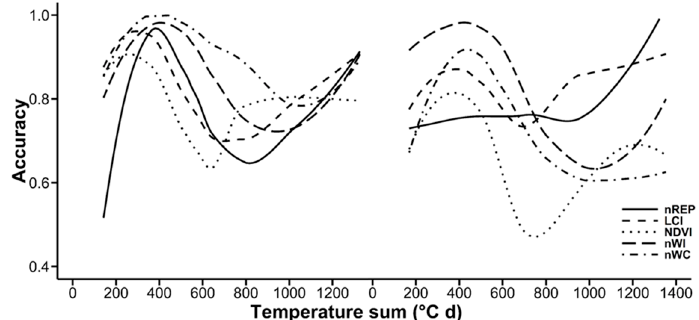
Figure 3. Accuracies of nREP, LCI, NDVI, nWI and nWC to distinguish plots at different T ∑ s. Raw data, including single data points, are deposited in Supplement Tables S5 and S6.